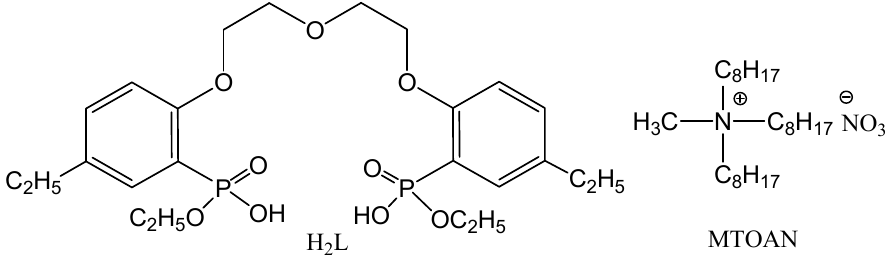
Figure 3. Molecular structures of 1,5-bis[2-(hydroxyethoxyphosphoryl)-4-ethylphenoxy]- -3- oxapentane and methyl trioctylammonium nitrate.